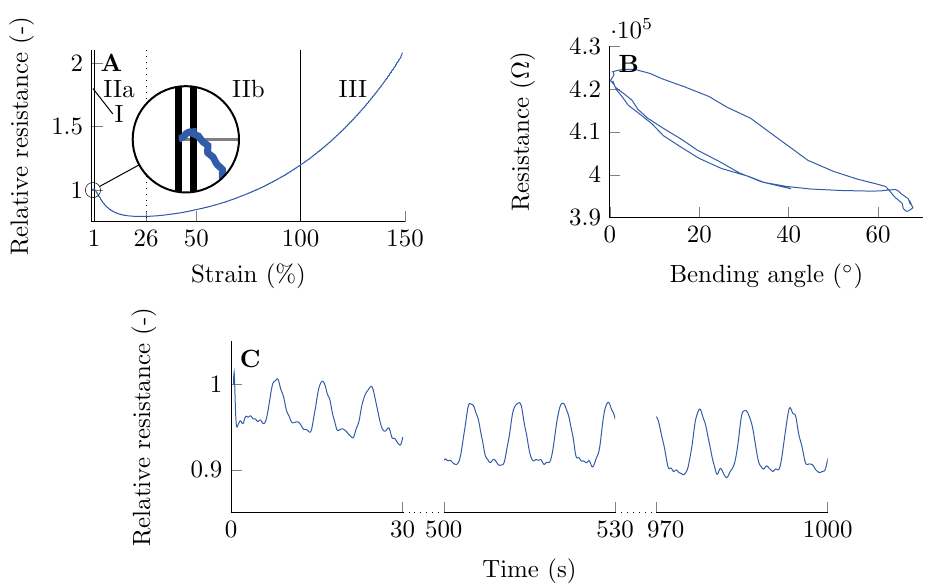
Figure 7. Characterization of the sensor. ( A ): Four zones can be distinguished in the fibre response. Zones I and IIa are the working domain of the sensor. Adapted from [12]. ( B ): The sensor embedded in the finger shows some hysteresis and reaches a maximal bending angle of 70 ◦ . ( C ): The finger is cyclically subjected from its rest position to its maximal bending angle. The sensor shows a drift of 3% after